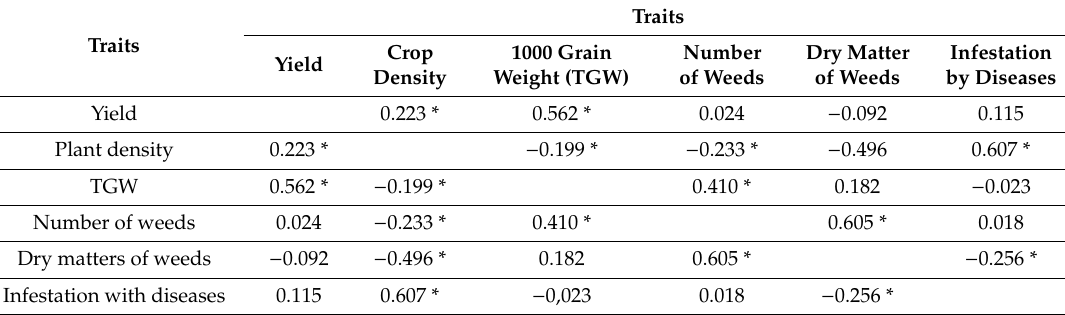
Table 5. Correlation coe ffi cients (r) among the tested traits ( n =